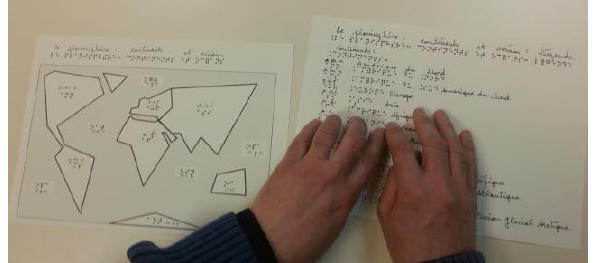
Figure 1. Example of a tactile map used by a visually impaired user during a geography lesson. The planisphere is simplified and presented on a sheet of paper. The legend is presented on a separate